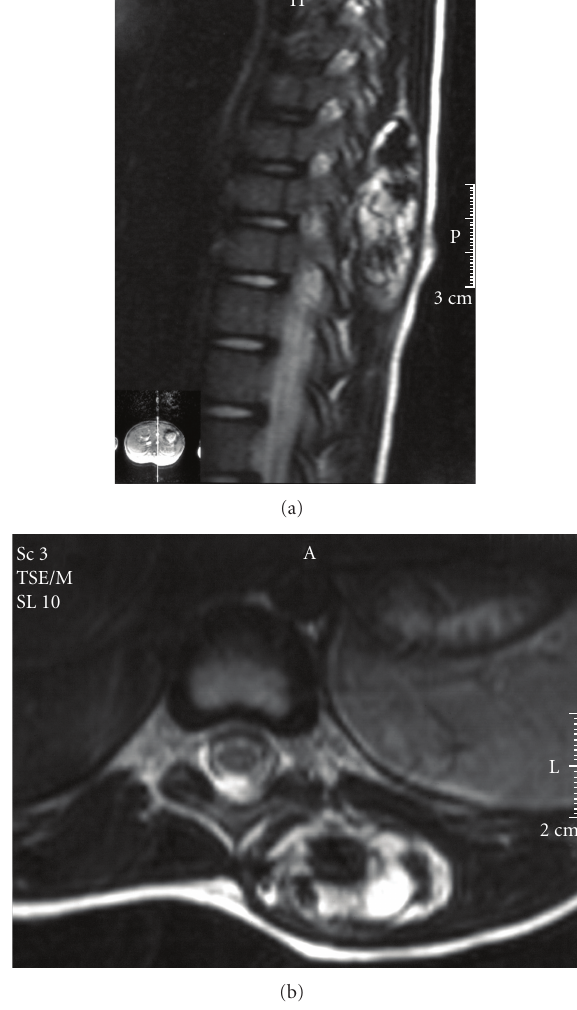
Figure 1: Sagittal and axial T2 weighted MRI images demonstrating a well-defined paraspinal mass.